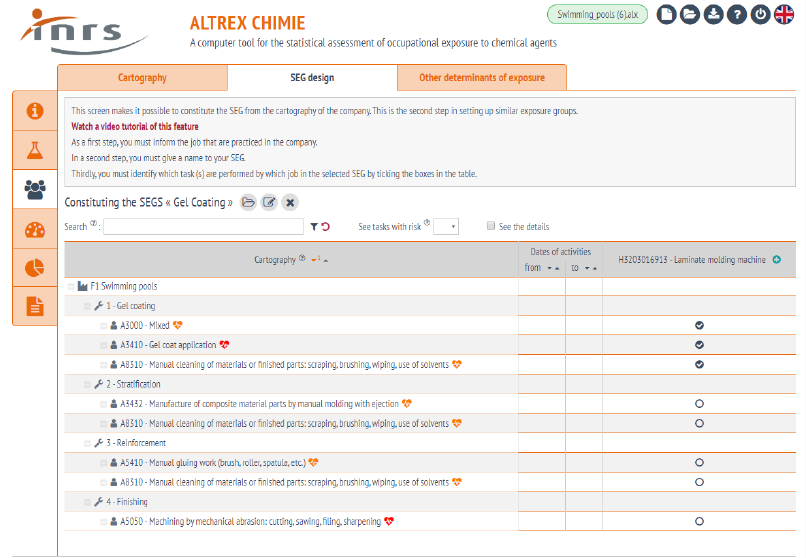
Figure 3. The design of SEGs: Hierarchical map of the factory listing the different fabrication steps; each task is associated with the substances and the definition of jobs. The last column shows where the tasks cross with jobs to define the SEG.